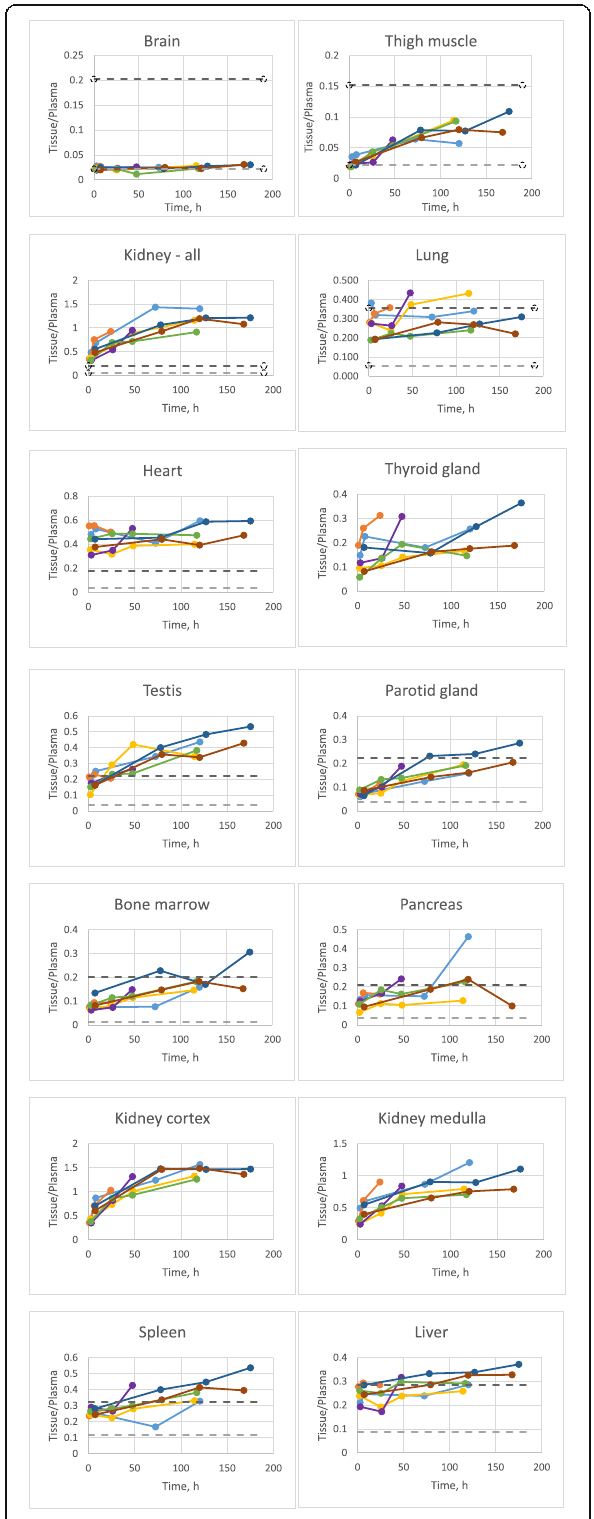
Fig. 5 Tissue-to-plasma ratios for different organs across time points for all subjects. The light gray dashed horizontal line denotes the estimated tissue-plasma ratio if the label was confined to the vasculature only. The dark gray horizontal dashed line denotes an estimation for when the label concentration in organ interstitial space is equal to that in plasma. Subject 105-light blue, 110-orange, 122-gray, 123-yellow, 125-purple, 127-green, 132-dark blue,